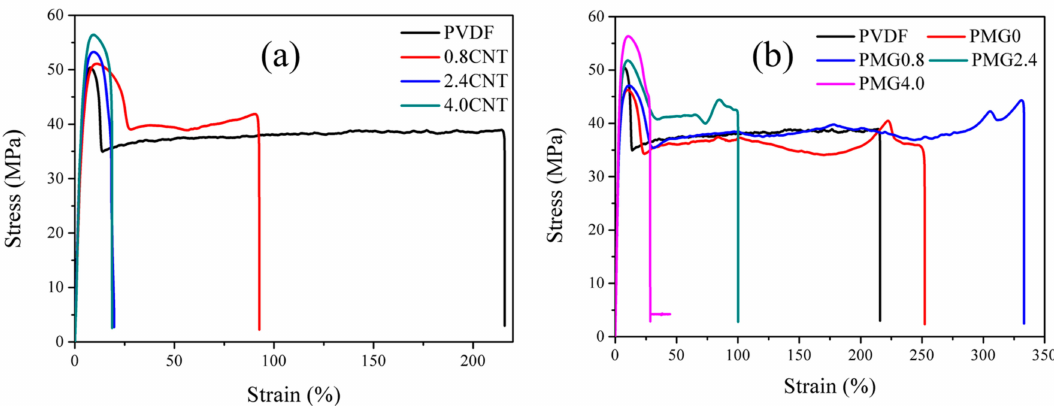
Figure 10. Stress-strain curves of ( a ) PVDF and c-MWCNTs/PVDF composites with 0.8 vol %, 2.4 vol % and 4.0 vol % c-MWCNTs; ( b ) PVDF, PMG0 and c-MWCNTs/MG/PVDF composites with 0.8 vol %, 2.4 vol % and 4.0 vol %